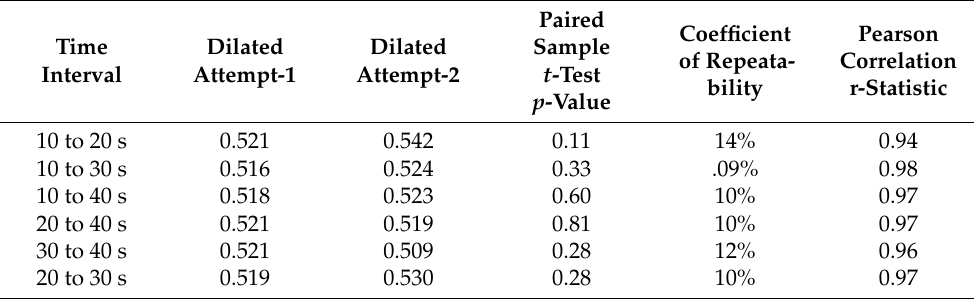
Table 9. Zeaxanthin optical density measurements obtained through pharmacologically dilated pupillary